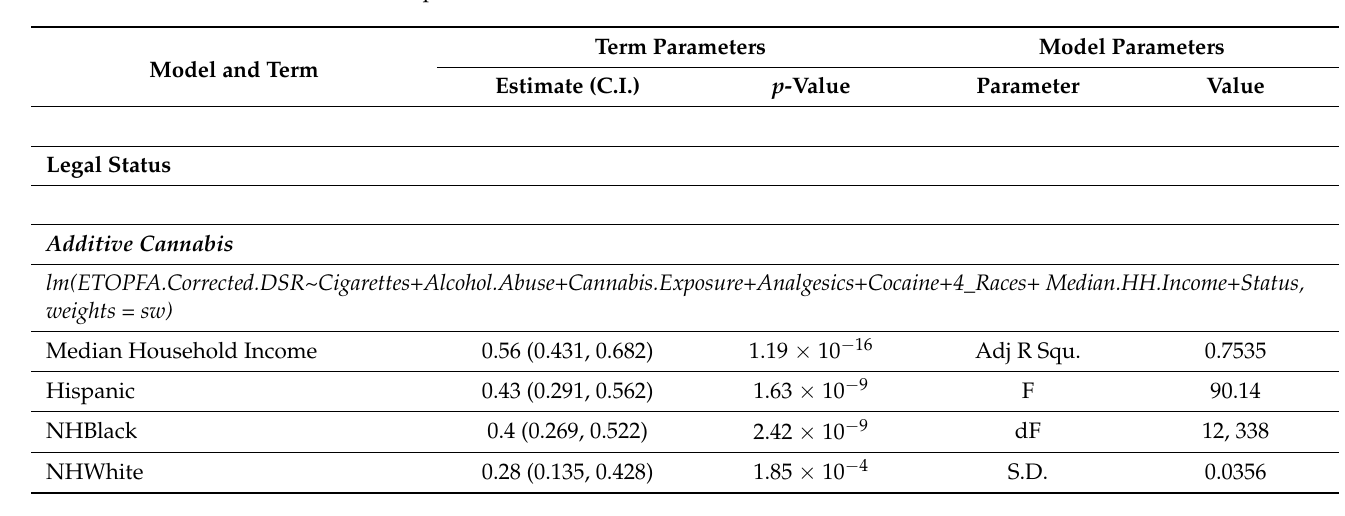
Table 7. Multivariable Linear Regression of Cannabis Legal Status. With ETOPFA-Corrected DSR as the Dependent